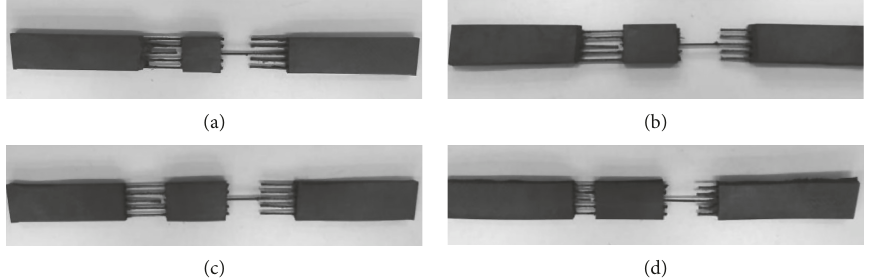
Figure 4: Splice samples of experiment. 50.0mm (a), 70.0mm (b), 80.0mm (c), and 100.0 mm (d) single steel cord sample. S, mises (avg: 75%)